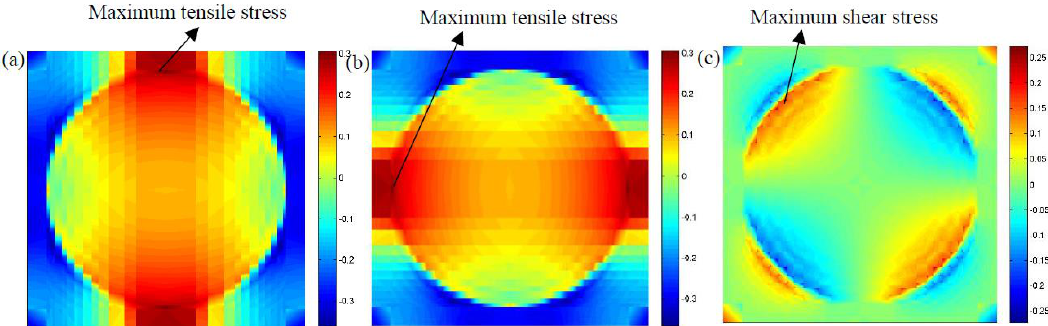
Figure 9. Microscopic stress distributions of the composites subjected to temperature variations at 5 s ( a ) σ 22 ( b ) σ 33 ( c ) σ 23